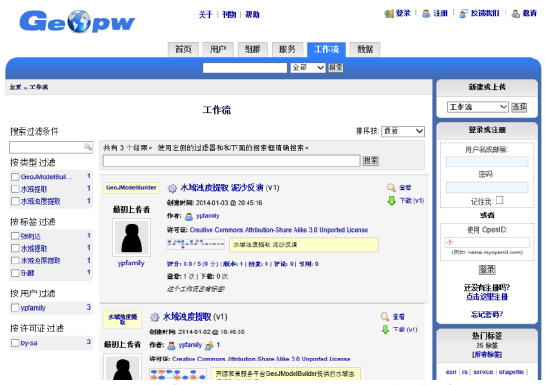
Figure 6. Workflow resources in the Web platform.